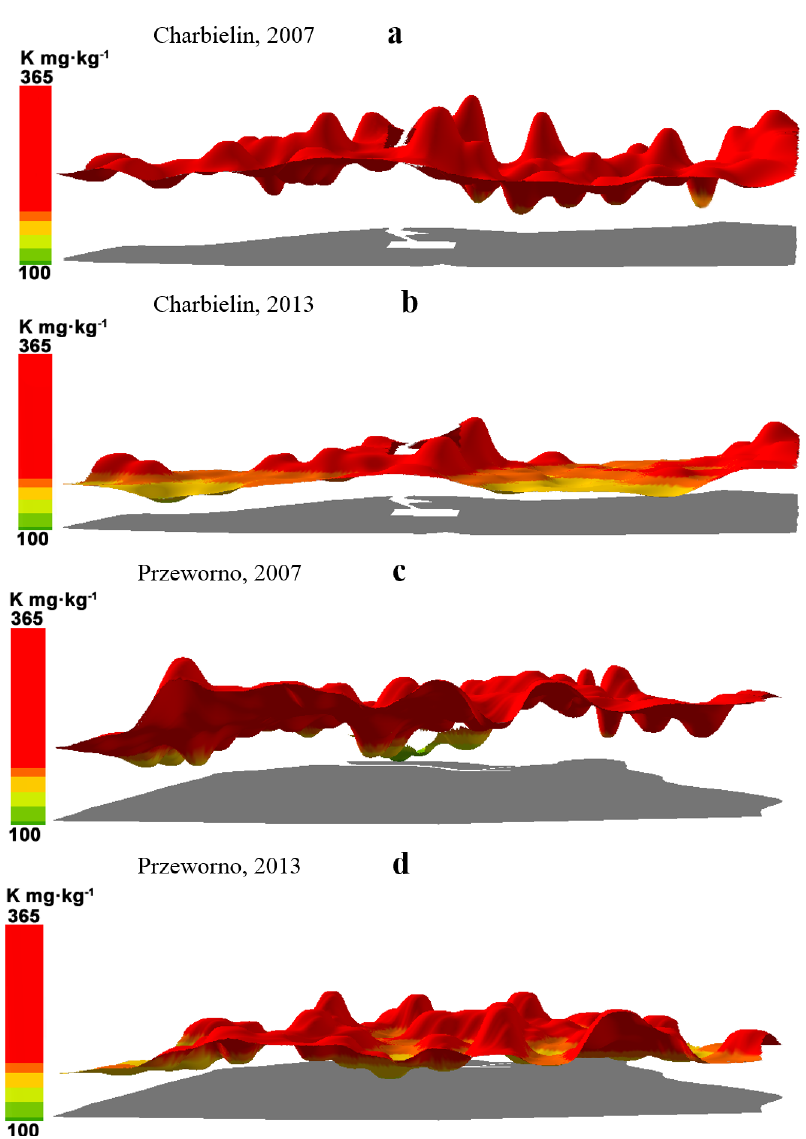
Figure 6: 3-D maps of the interpolated K contents determined in Charbielin (heavy soils) and Przeworno (light soils) at the beginning (2007) and at the end of the experiment